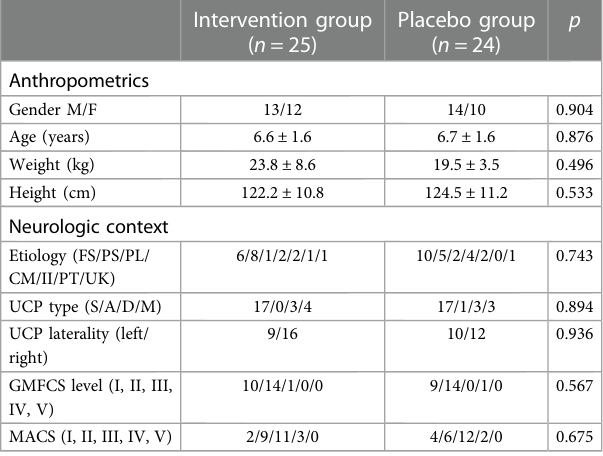
TABLE 3 Frequency reasons of non-adherence of Lycra ® sleeve wearing between UCP children allocation groups.